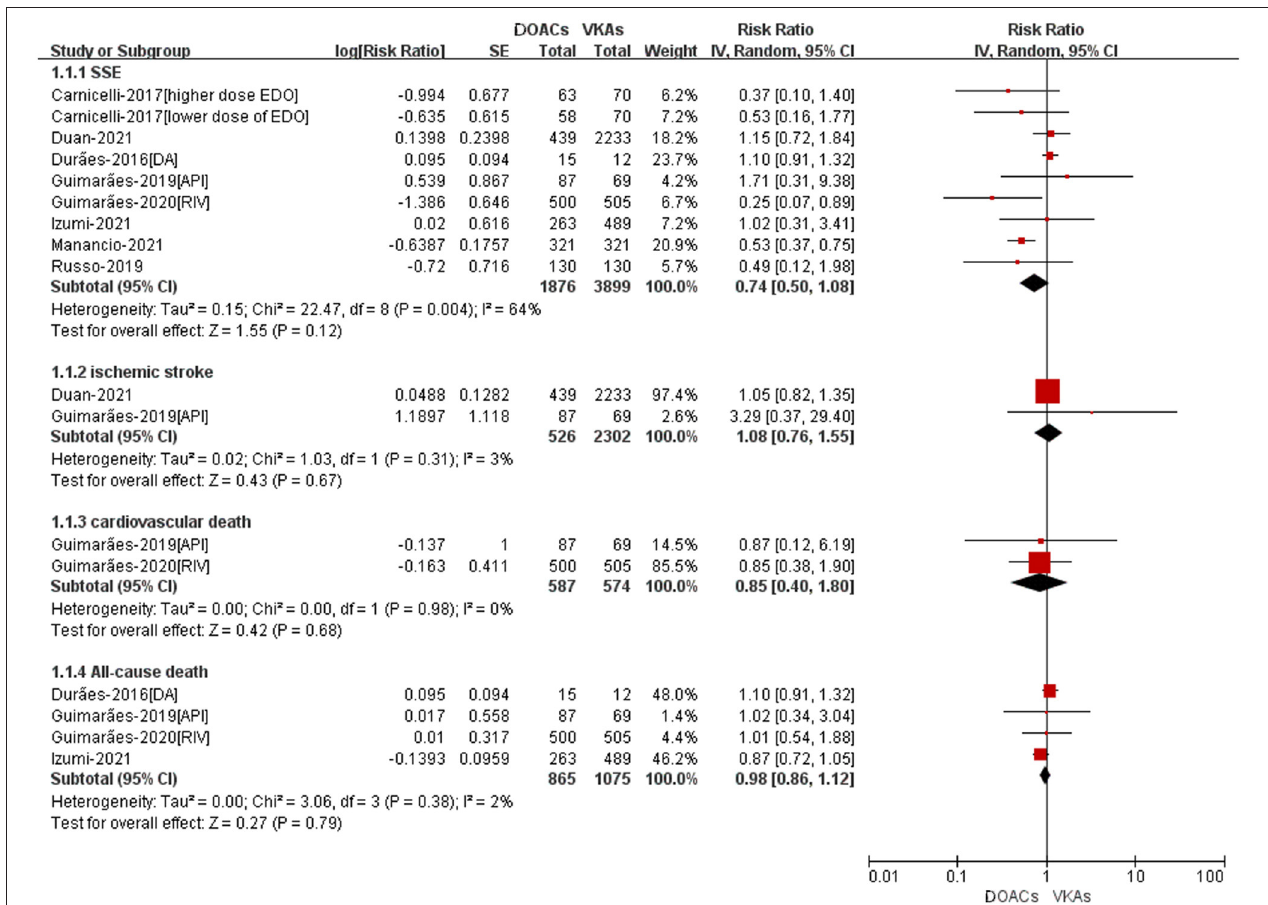
FIGURE 2 | Adjusted effectiveness data of DOACs compared with VKAs among AF patients with BPHV. SSE, Stroke or systemic embolism; RCTs, randomized controlled trials; DOACs, direct-acting oral anticoagulants; CI, confidence interval; VKAs, vitamin K